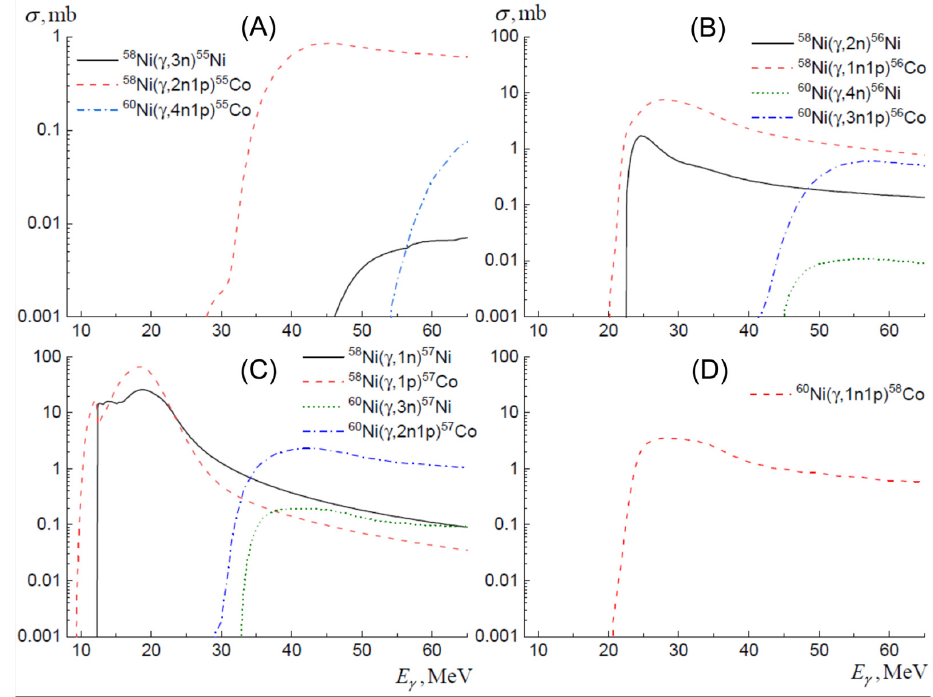
Figure 4. Calculated cross-sections of the main photonuclear reactions leading to the formation of 55 Co and 55 Ni ( A ), 56 Co and 56 Ni ( B ), 57 Co and 57 Ni ( C ), and 58 Co ( D ) .